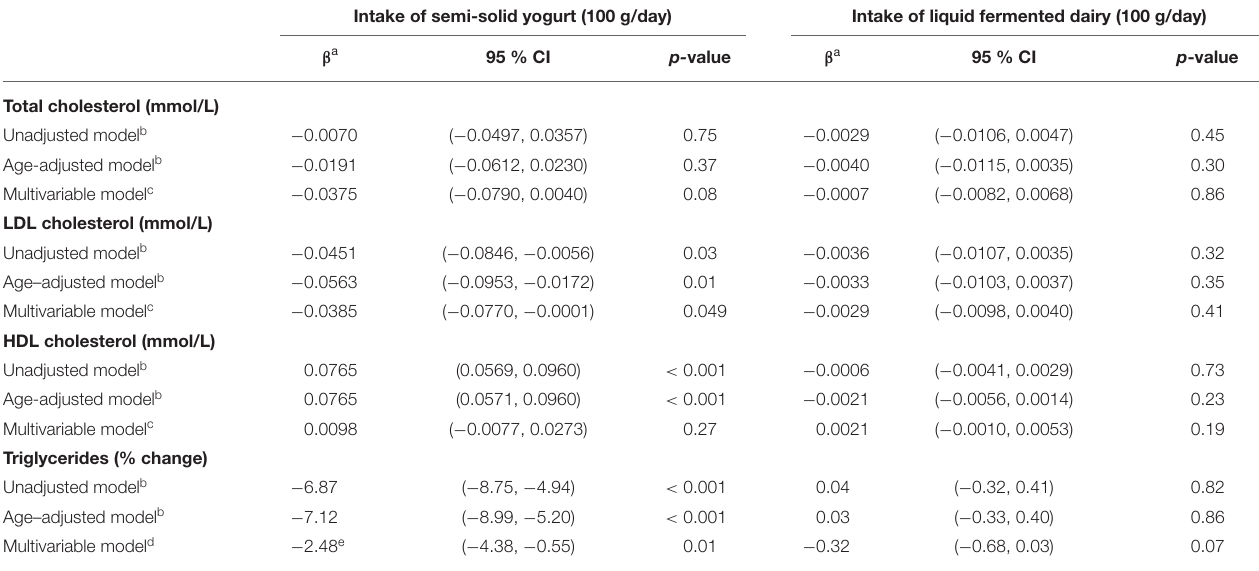
TABLE 4 | Linear regression coefficients for the associations between blood lipids and intake of semi-solid yogurt and intake of liquid fermented dairy. The Tromsø Study: